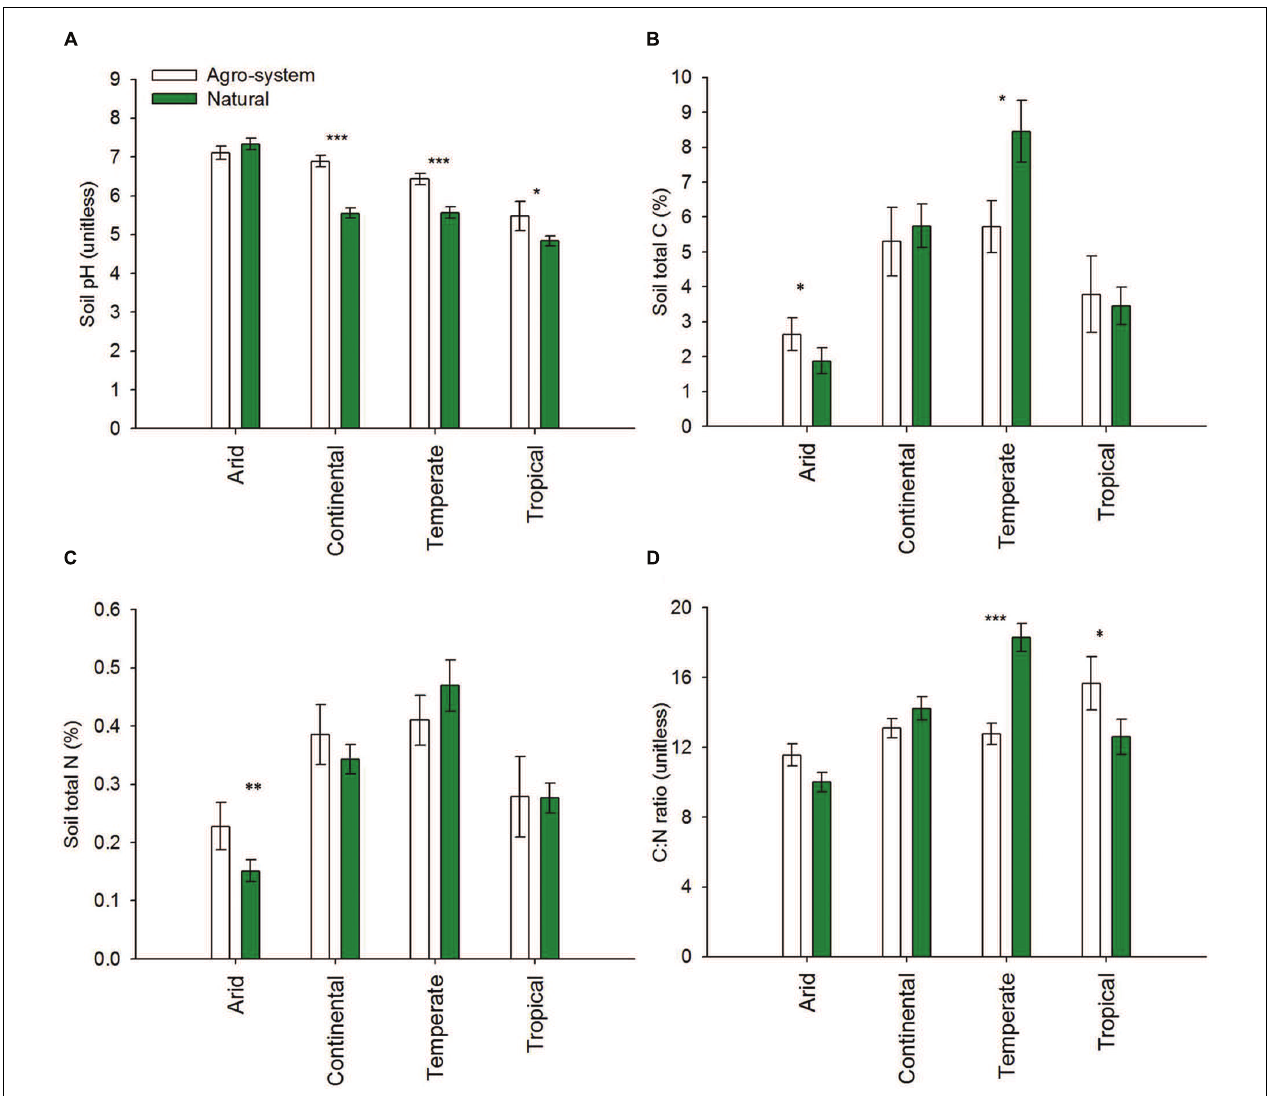
FIGURE 3 | Soil chemical properties [(A) Soil pH; (B) Soil total C (%); (C) Soil total N (%); and (D) C/N ratio] of agricultural vs. natural systems in arid ( n = 26 and 70), continental ( n = 43 and 119), temperate ( n = 82 and 128) and tropical ( n = 14 and 36) regions. The sites were selected based on a meta-analysis consisting of both published and unpublished data wherein bacterial diversity and compositions is described based on next generation sequencing techniques (either 454 or Miseq; see Material and Methods for more details). The main climate classes are based on global maps available for the most frequently used Köppen climate classification map (Kottek et al., 2006). ∗ P < 0.01; ∗∗ P < 0.001; ∗∗∗ P <